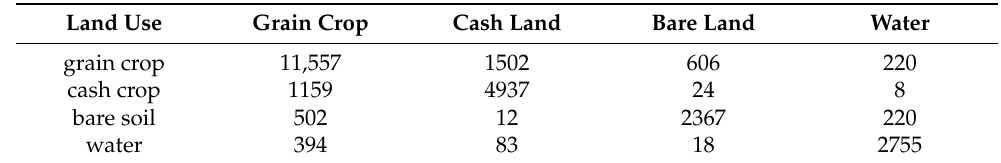
Table 6. Confusion matrix of crop classification obtained from SVM using the GLCM parameter dataset extracted from Sentinel-1 time-series dataset in